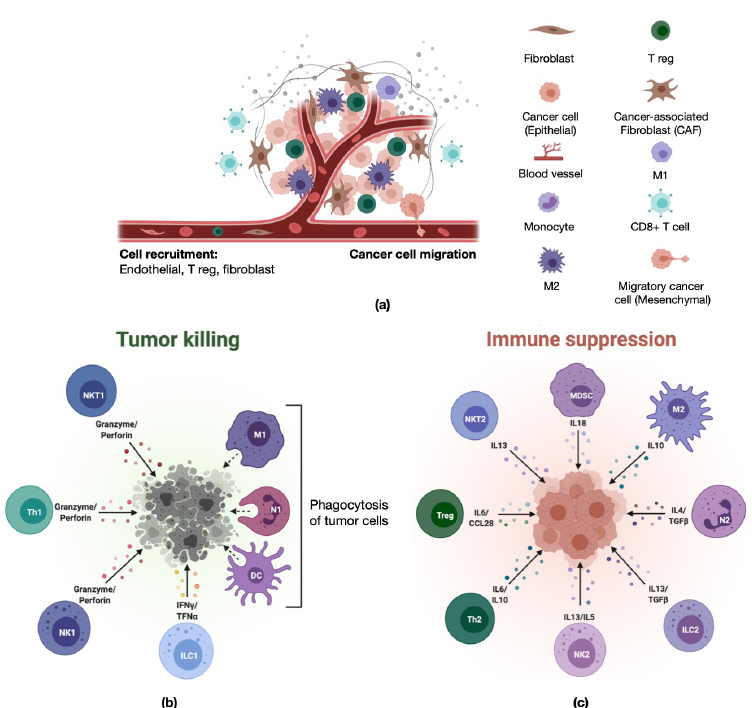
Figure 1. Schematic representation of the tumor microenvironment and its cellular composition. ( a ) Tumor microenvironment. Graphic representing various cellular components of vasculature and tumor microenvironment [20]. ( b , c ) Immune cell composition in the tumor microenvironment: cellular and molecular components involved in pro-inflammatory, tumor-killing activity ( b ) and anti-inflammatory, immunosuppressive, tumor-promoting activity ( c )